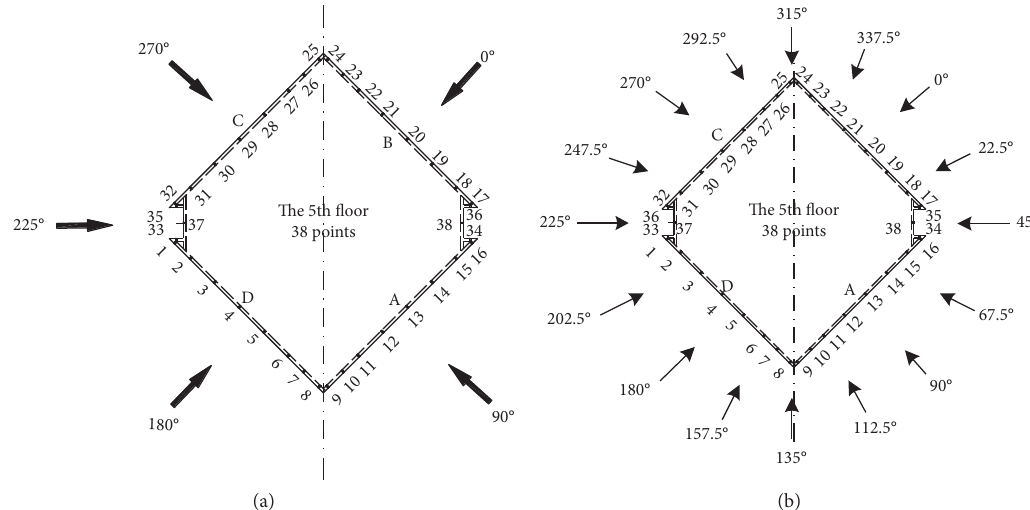
Figure 8: Cross section of the 5 th measurement level and definition of wind direction angle. Table 1: Peak factor of the Gaussian model and corresponding unilateral and bilateral guarantee rates.